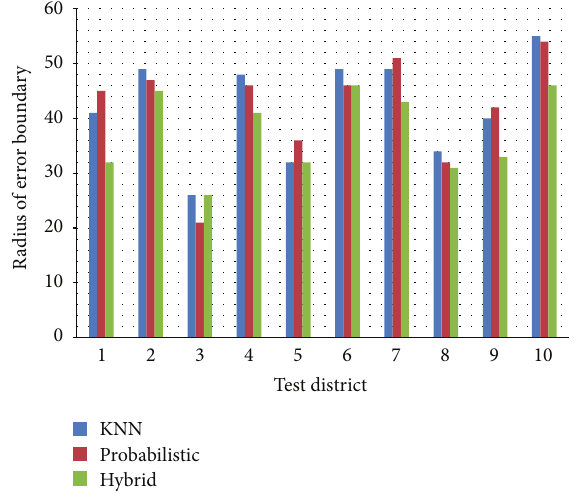
Figure 14: Comparison of radius of error